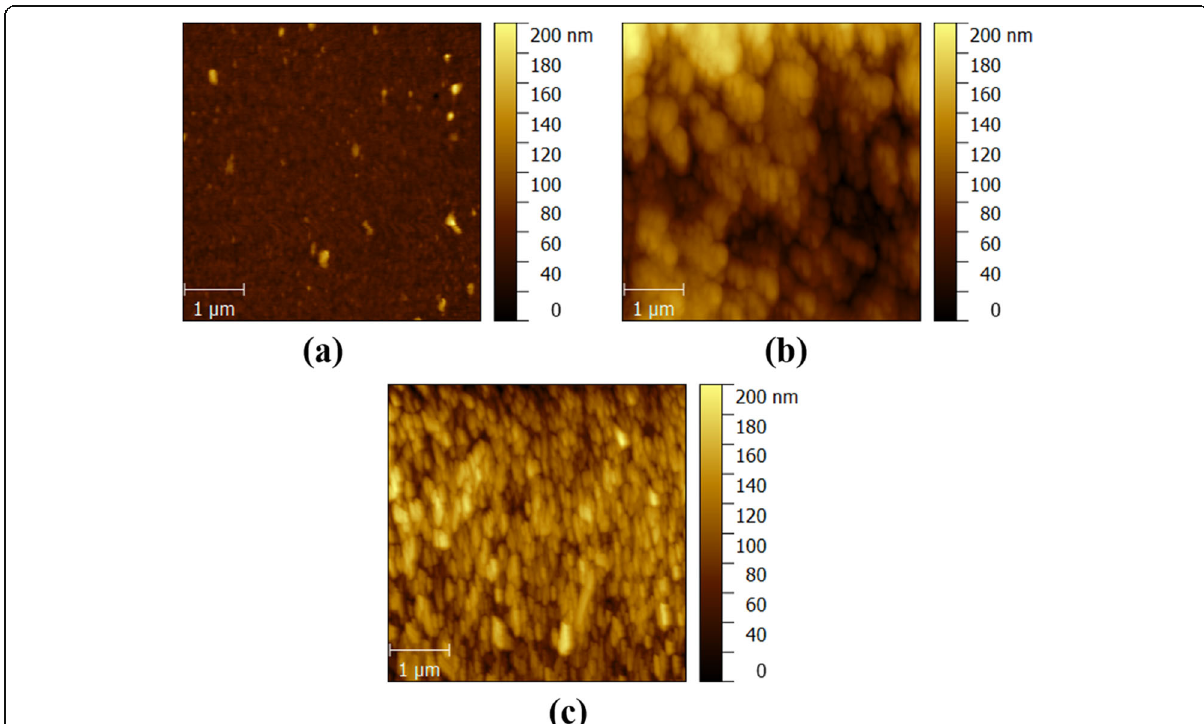
Fig. 4 AFM images of a as-deposited poly-Ga 2 O 3 on sapphire, b samples annealed at 800 °C, and c 900